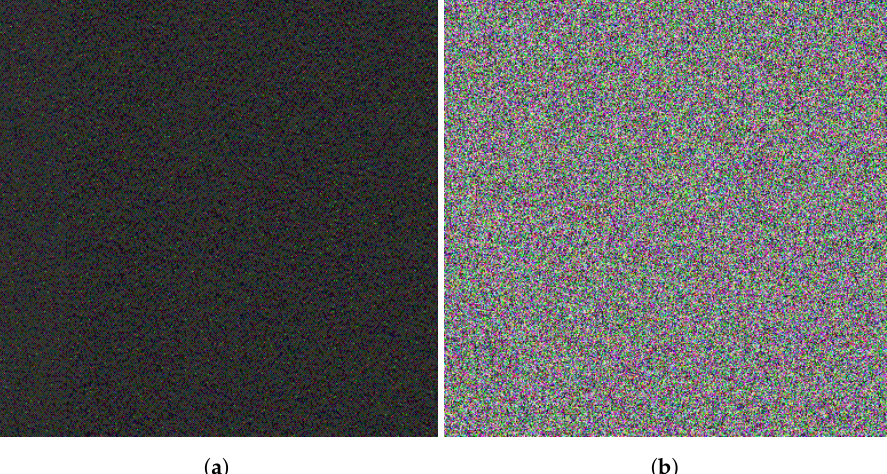
Figure 6. Test File 3 text message as image png and its cipher-image. ( a ) Text message in image form. ( b ) Encrypted